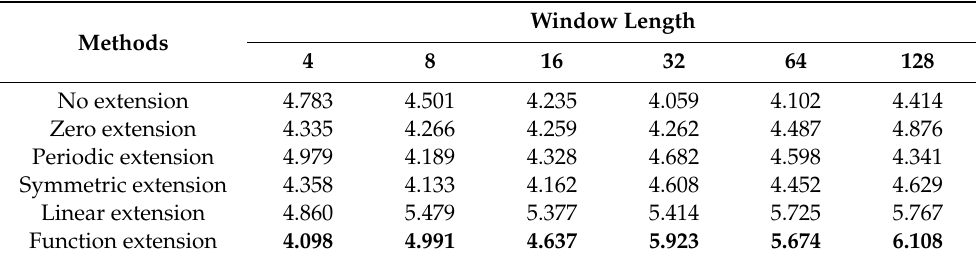
Table 3. The single calculation period results of different extension methods (ms).